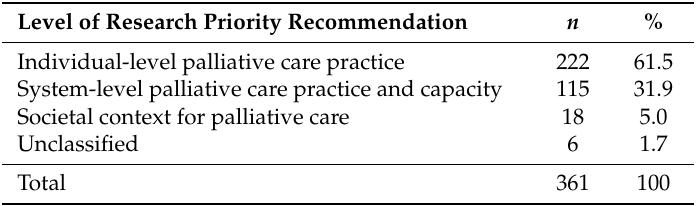
Table 8. Distribution of scientific production by level of research priority recommendation ( n and %).